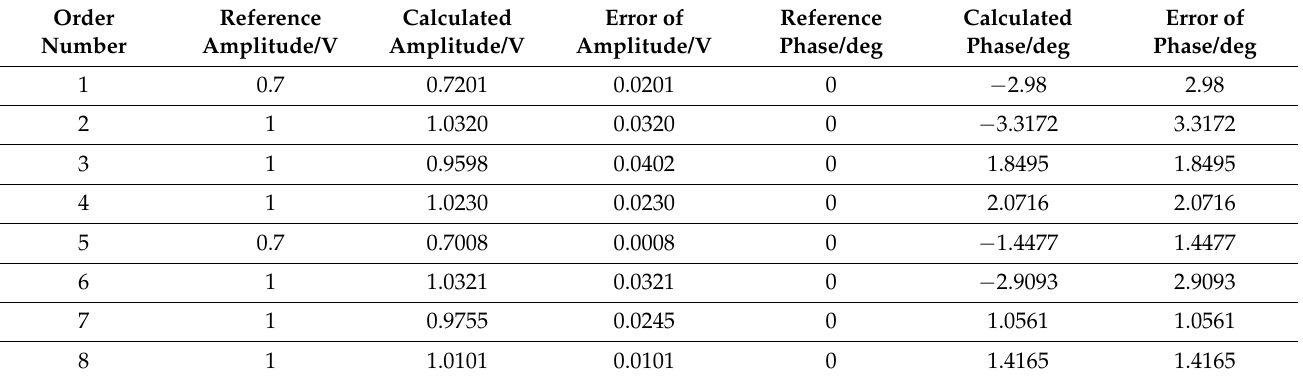
Figure 11. Comparison between the calculated pattern and the reference pattern. Suppose that the attenuator failure occurs in units 1 and 5 of the phased array antenna. Set the feed of units 1 and 5 as amplitude 0.7 V and phase 0 deg. Further, other units are excited with amplitude 1 V and phase 0 deg. The calculation results are shown in Table 2. Table 2. The initial feed and the calculated feed amplitude and phase.